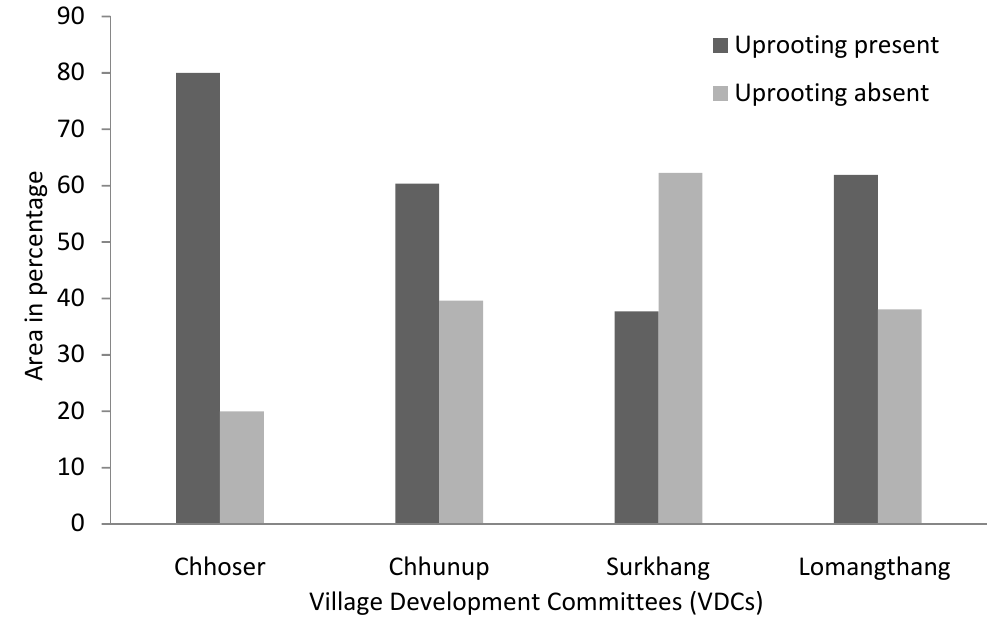
Figure 4. Percentage of area in which uprooting of plants by local people was observed in the brown bear habitat of the upper Mustang